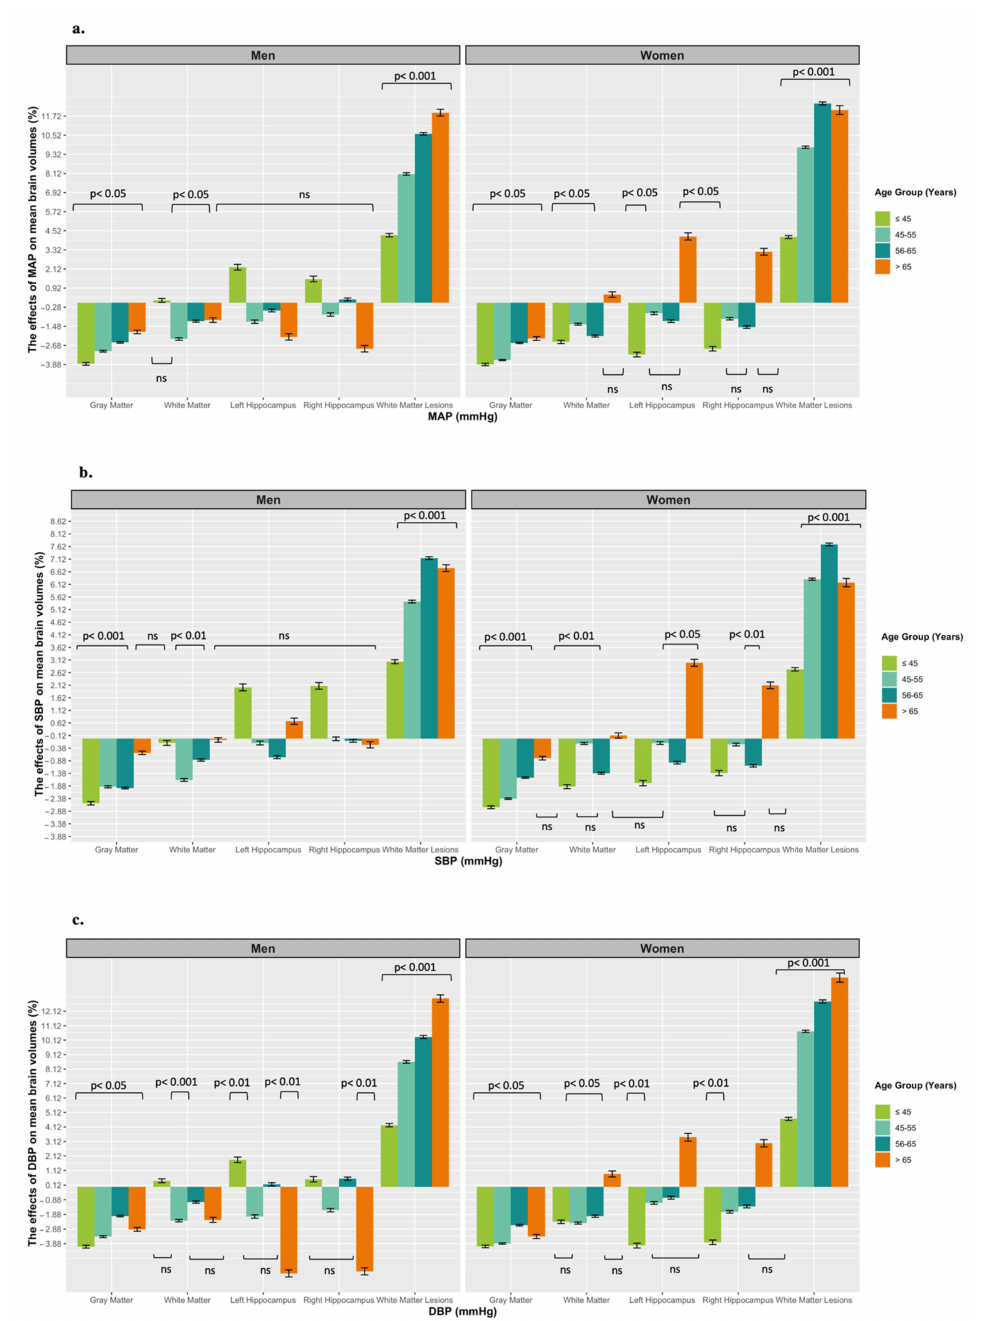
Figure 1. The proportion effects of BP including ( a ) mean arterial pressure (MAP), ( b ) systolic blood pressure (SBP), ( c ) diastolic blood pressure (DBP), on the brain volumes including gray matter, white matter, left and right hippocampus and white matter lesions, across age groups in men and women. Association presented as unstandardized beta coefficient and corresponding standard error